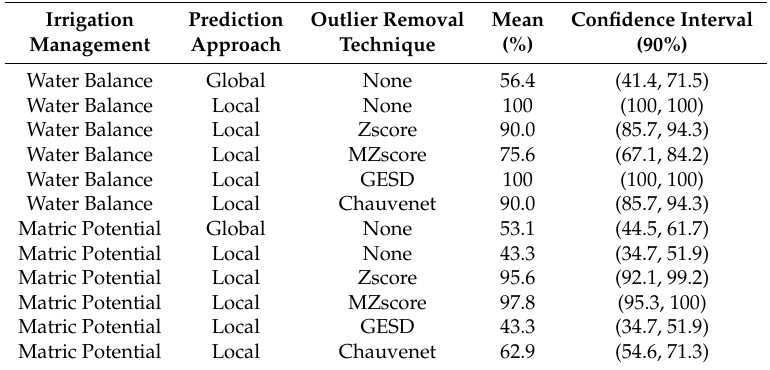
Table 6. Percentage of water saved in six months by irrigation management using predicted soil moisture